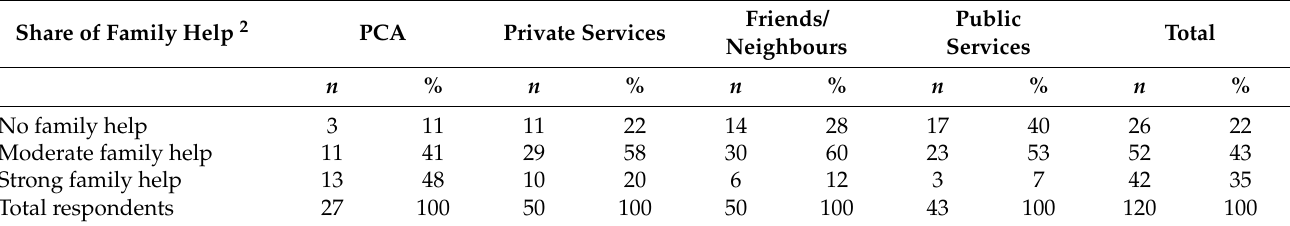
Table 8. Share of family help on the total and other supports 1